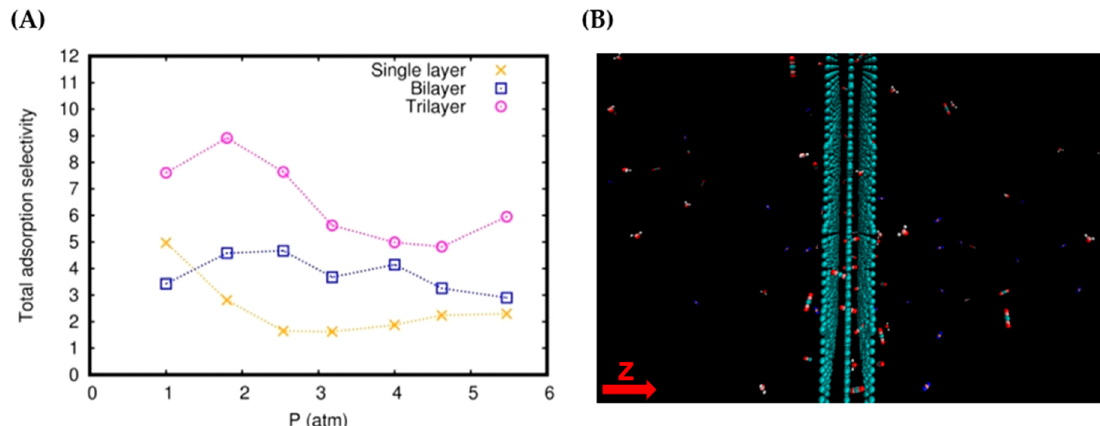
Figure 10. Total adsorption selectivity of CO 2 /N 2 at 333 K ( A ) and a snapshot of the configurations for the trilayer system at 4.62 atm and 353 K ( B ).